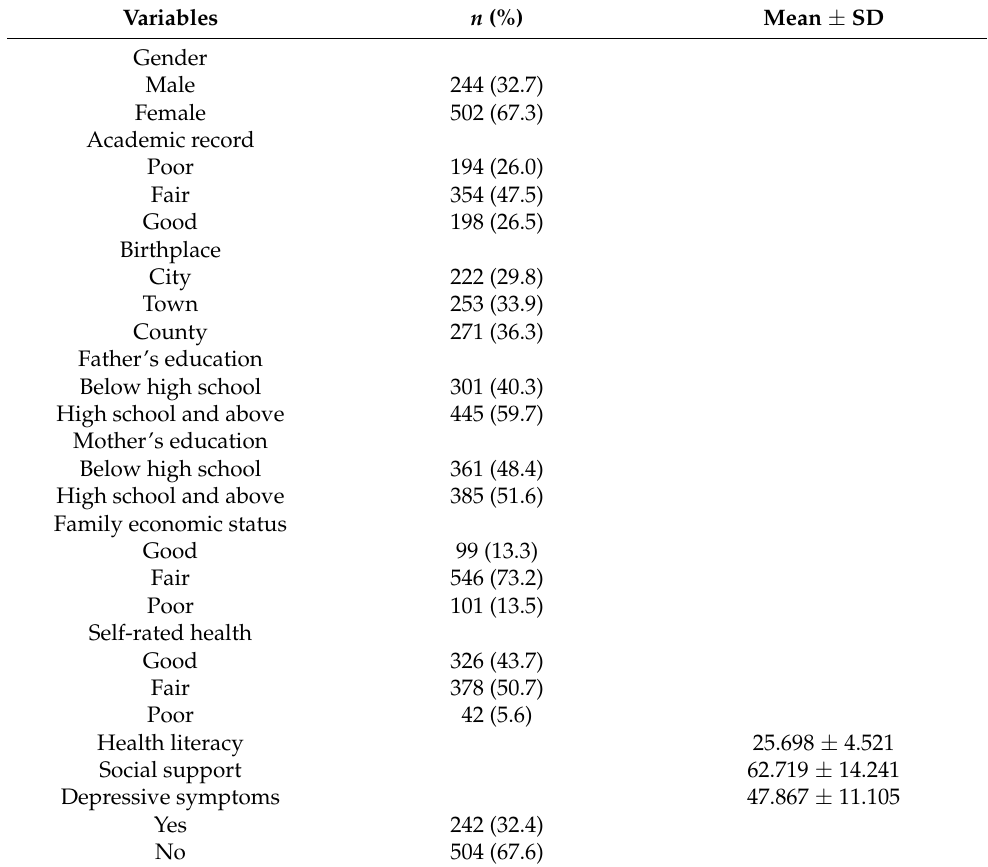
Table 1. Characteristics of medical college